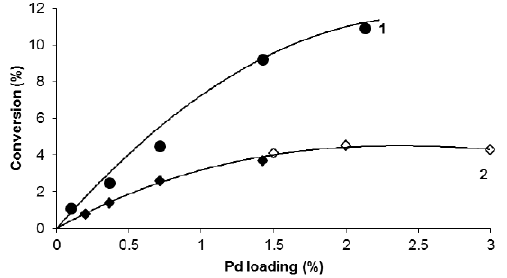
Figure 1. Effect of Pd loading on benzene conversion for benzene alkylation at 300 °C over (1) 7.1%Pd/C + HZSM ‐ 5 catalysts and (2) Pd ‐ HSiW including physically mixed catalysts 7.1%Pd/C + 25%HSiW/SiO 2 (solid diamonds) and supported catalysts Pd/25%HSiW/SiO 2 (open diamonds) (for reaction conditions, see Tables 1 and 2).